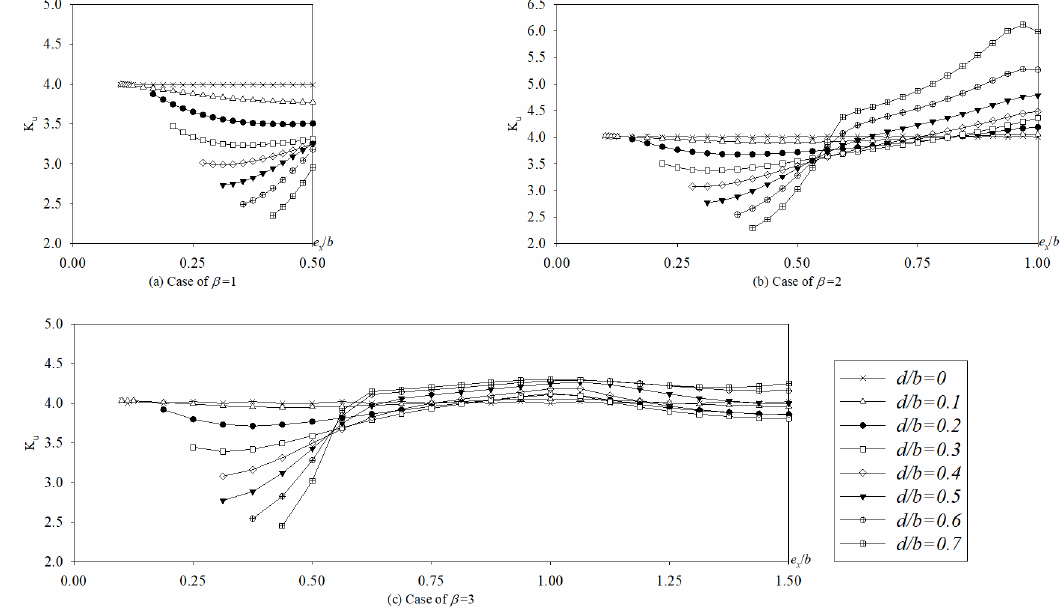
Figure 16. K u vs. e x / b for perforated rectangular plate ( β = 1, 2, 3, 4) with the BCs of 4S.